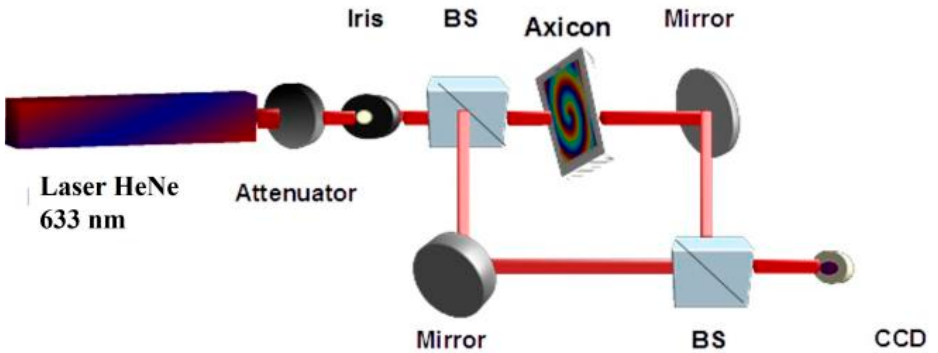
Figure 12. Optical setup for the generation of intensity and wavefront distribution for Bessel–Gauss beams.